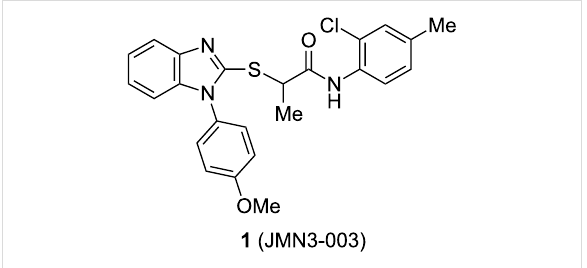
Figure 1: Structure of first-generation lead compound 1